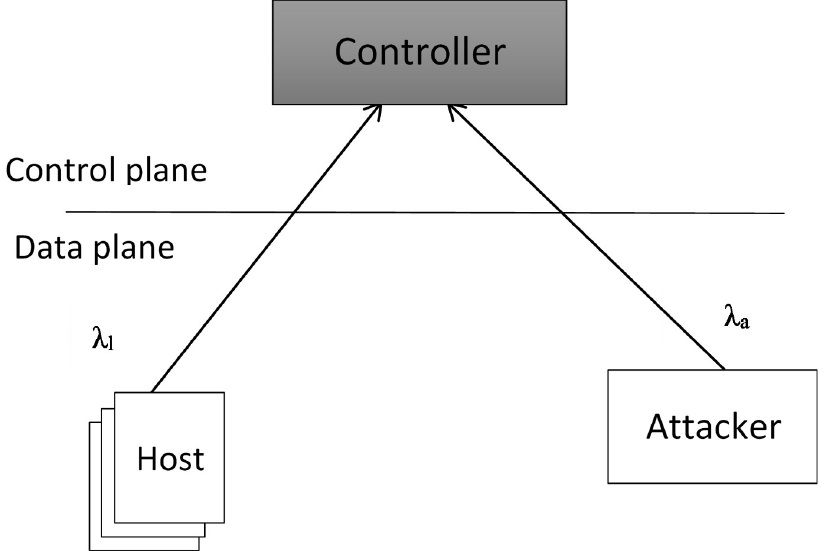
Fig 5. Abstracted simulation of the detection system.